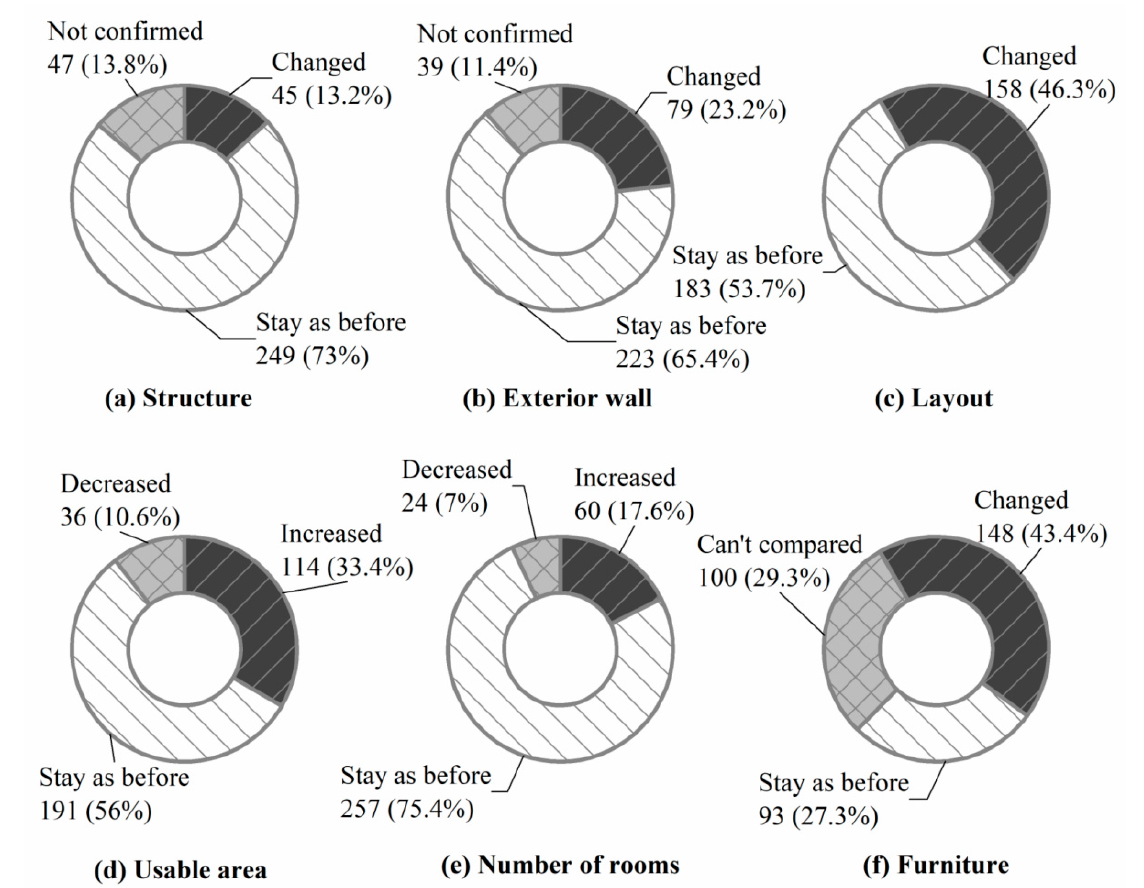
Figure 1. Distribution of the renovation status of different contents.